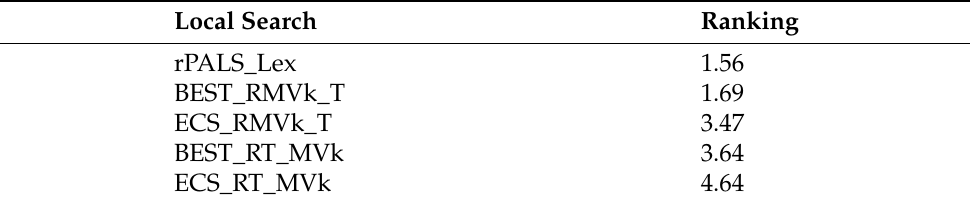
Table 16. Energy Friedman ranking on the 400 scheduling problems (t-level).